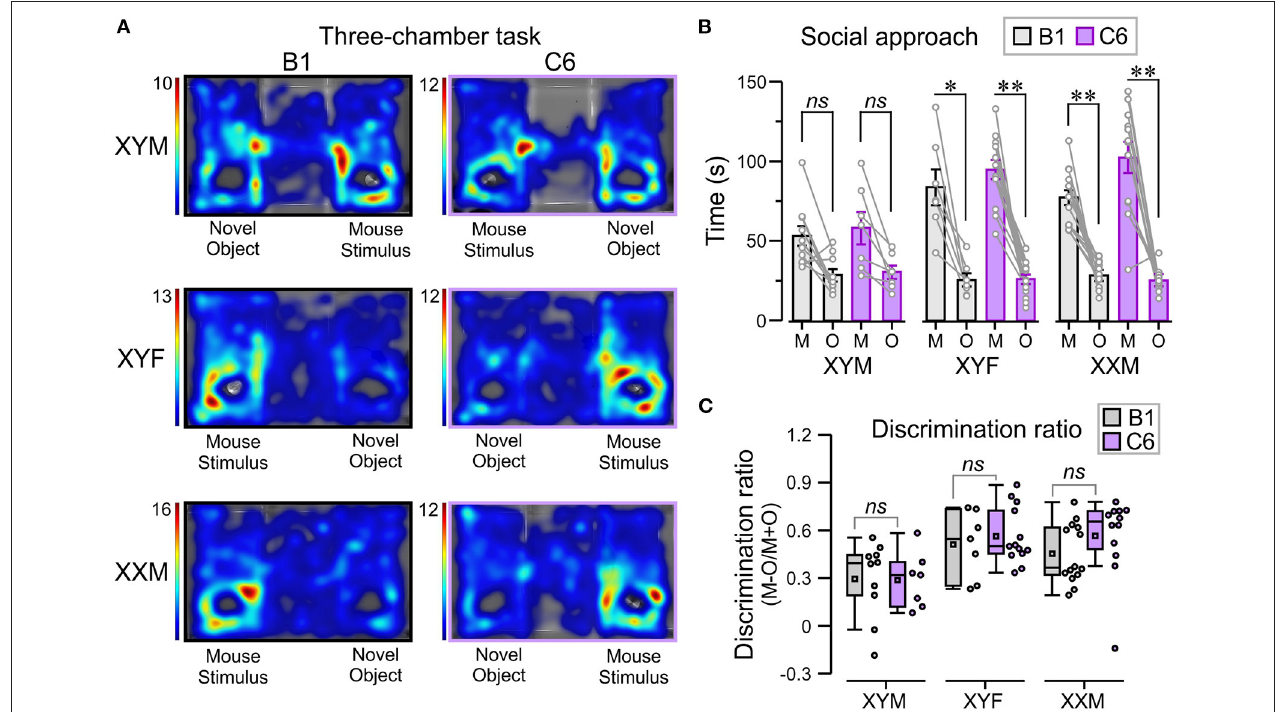
FIGURE 5 | In utero C6 exposure did not affect social approach. We used the three-chamber task to evaluate social approach. The number of mice per group was: B1-XYM = 10, C6-XYM = 7, B1-XYF = 7, C6-XYF = 13, B1-XXM = 14, and C6-XXM = 12. (A) Representative trials of the social approach session displayed as top-view heatmaps for individual B1- and C6-exposed XYM, XYF, and XXM mice. (B) Time (mean ± SEM) spent interacting with the novel object (O) and the “mouse-stimulus” (M). The lines linking each mouse-stimulus and object represent the scores for individual subjects. All the groups tested showed social preference for the mouse-stimulus compared to the novel object; 3-way ANOVA with Tukey test was used for these comparisons. (C) Box-and-whisker plots show the discrimination ratio for social interaction. C6- and B1-exposed mice displayed similar discrimination between mouse-stimulus and novel object, irrespective of genotype; 2-way ANOVA with Tukey test was used for these comparisons. See Table 1 and Supplementary Table 2 for details of statistical testing; ns , non-significant, * P < 0.05, ** P < 0.001.